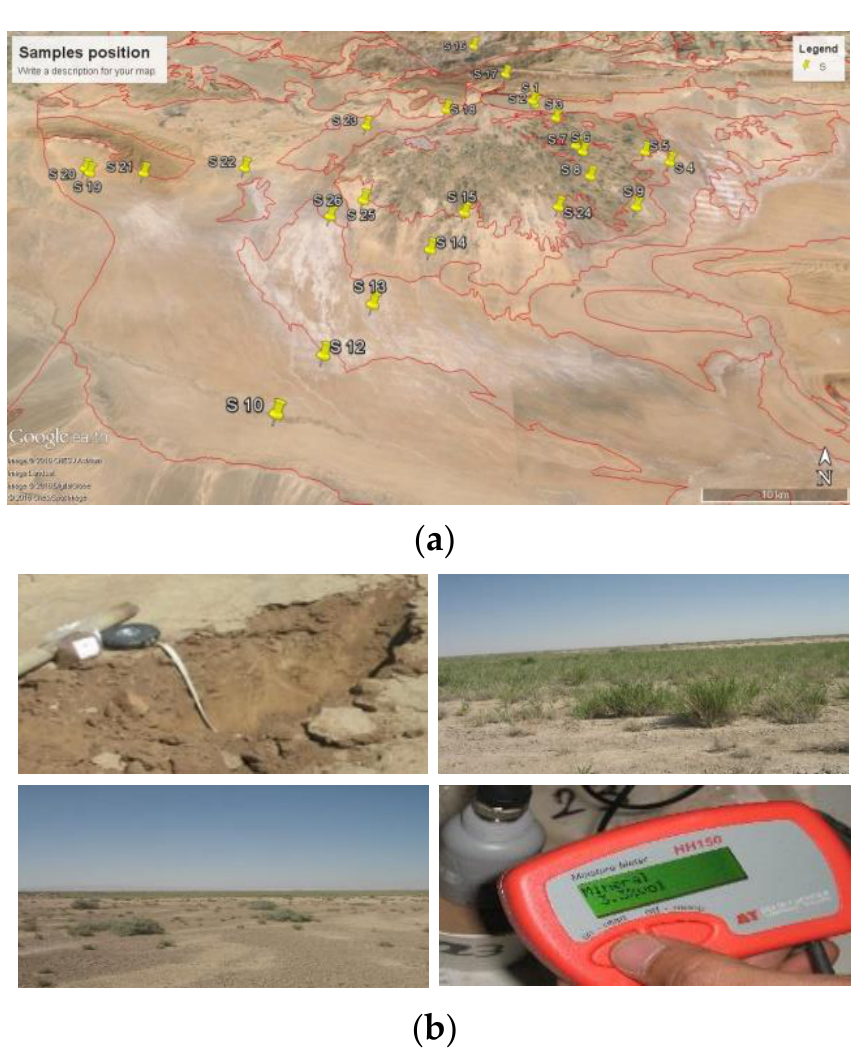
Figure 4. ( a ) The footprint of the LUA map outlined by a red line and sample points in Google Earth and ( b ) the landscape of some LUA in the field work and SM measurement by TDR.